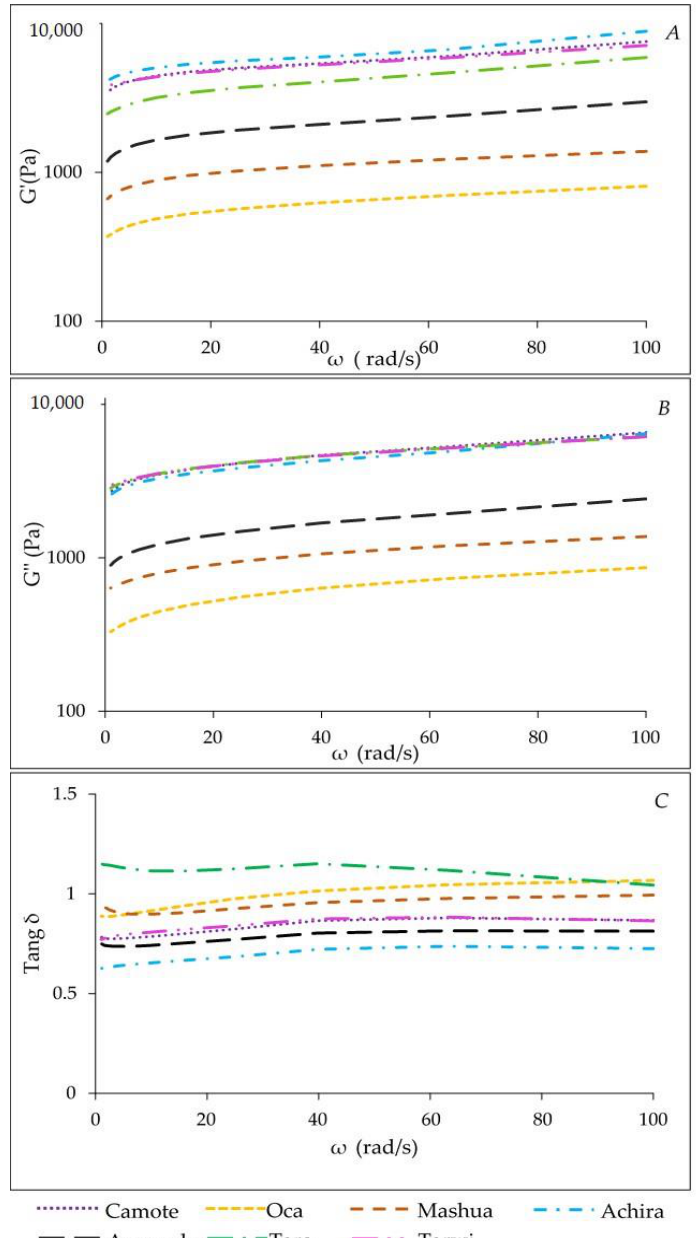
Figure 5. Mechanical spectra of dynamic rheological properties of flours vs. frequency (rad/s). ( A ) Storage modulus (G (cid:48) , Pa); ( B ) loss modulus (G (cid:48)(cid:48) , Pa); ( C ) loss factor tang δ . Mashua and oca flours showed lower G (cid:48) and G (cid:48)(cid:48) , resulting in a weak gel